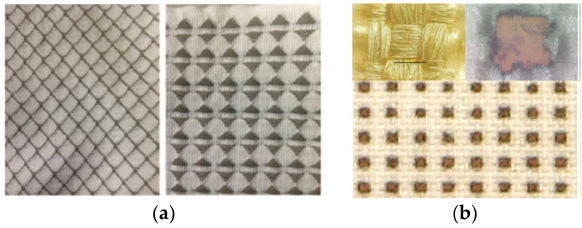
Figure 22. ( a ) Two knitted, conducting textile FSSs with conducting grid (Left), conducting patch (Right), white area knitted from polyester yarn & dark areas knitted from conducting yarn [192] ( b ) Microscopic image of screen printed fabric FSS [191]. ( a , b ) Adapted from [191,192] and reproduced by permission of the Institution of Engineering &